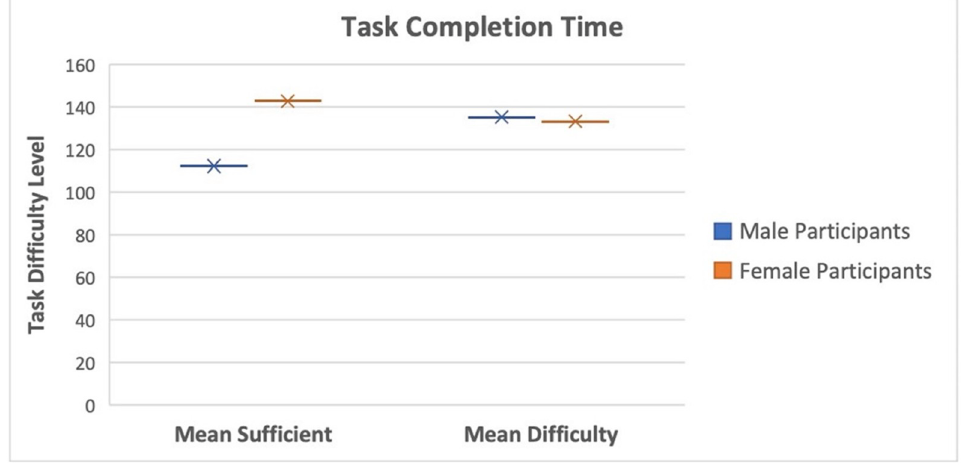
Fig 3. Relationship between difficulty level and mean task completion time. Participants spent much time completing the task as the task difficulty level